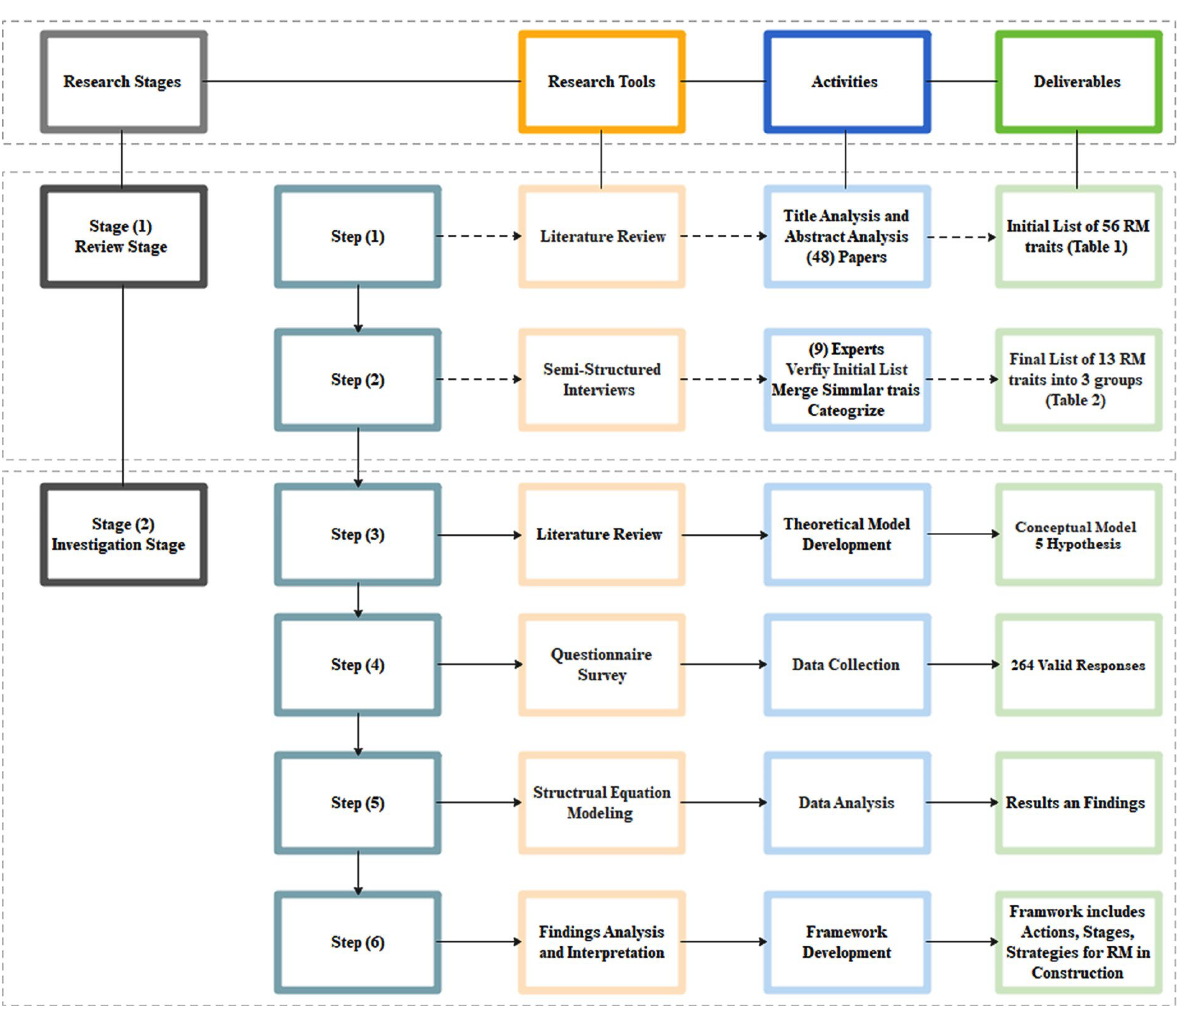
Figure 1. Research